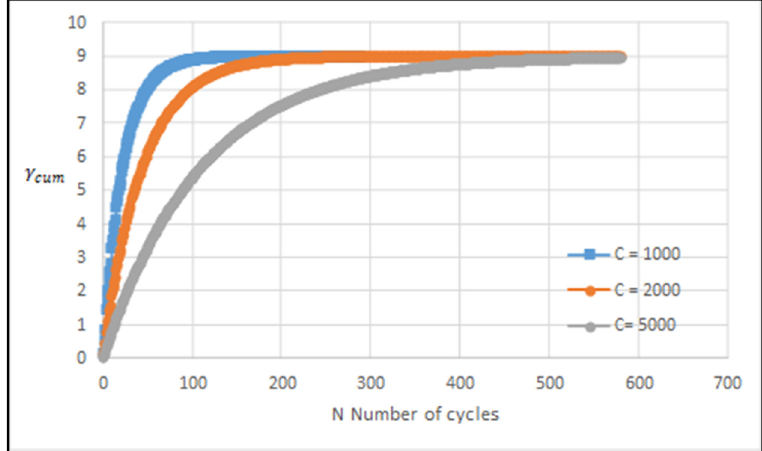
Figure 6. Effect of kinematic hardening on the accumulated plastic strain γ cum.